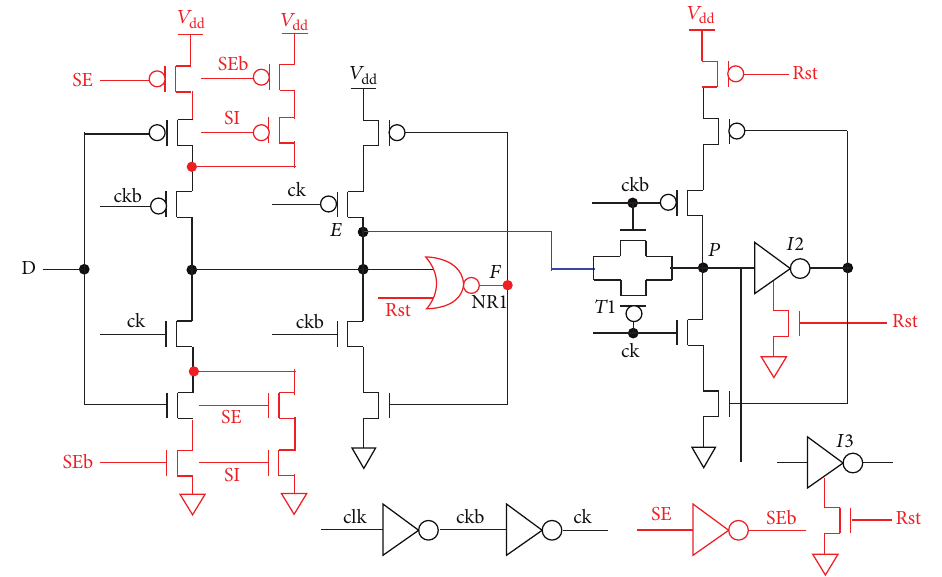
Figure 7: Proposed C2DPFF with scan logic.